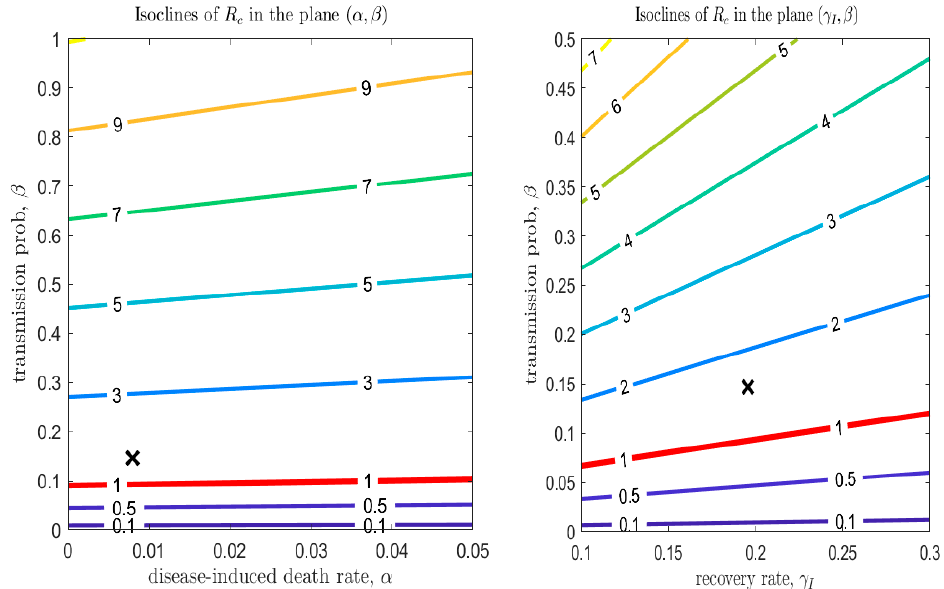
Figure 12. Left panel: values of R c in the plane ( α , β ) . Right panel: values of R c in the plane ( γ I , β ) . The other parameters are those estimated on March 24. The red line corresponds to R c = 1 (dashed lines showing confidence intervals).